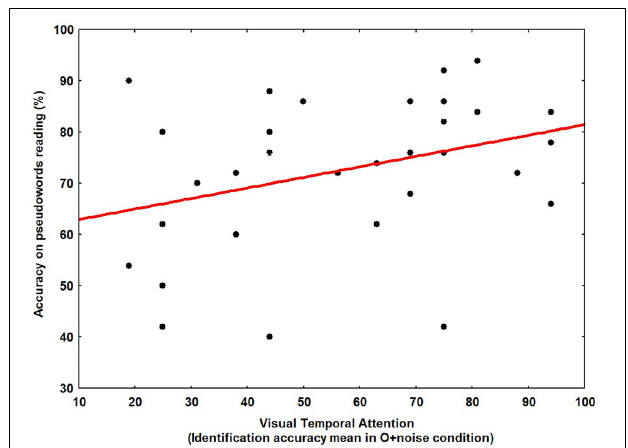
FIGURE 7 | Scatter plot of the relationship between visual temporal attention (identification accuracy mean in O + noise condition) and pseudoword reading accuracy across our entire sample of dyslexic children ( N =